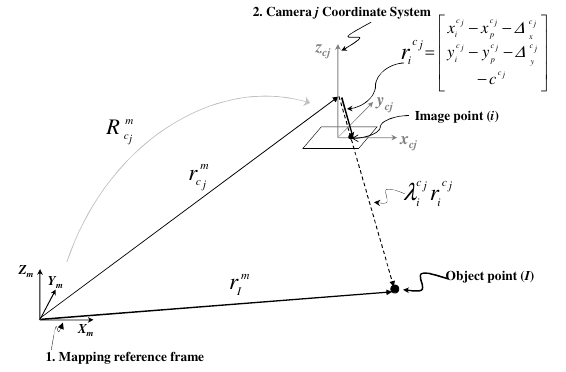
Figure 1. Involved parameters in the vector summation process to derive the conventional collinearity